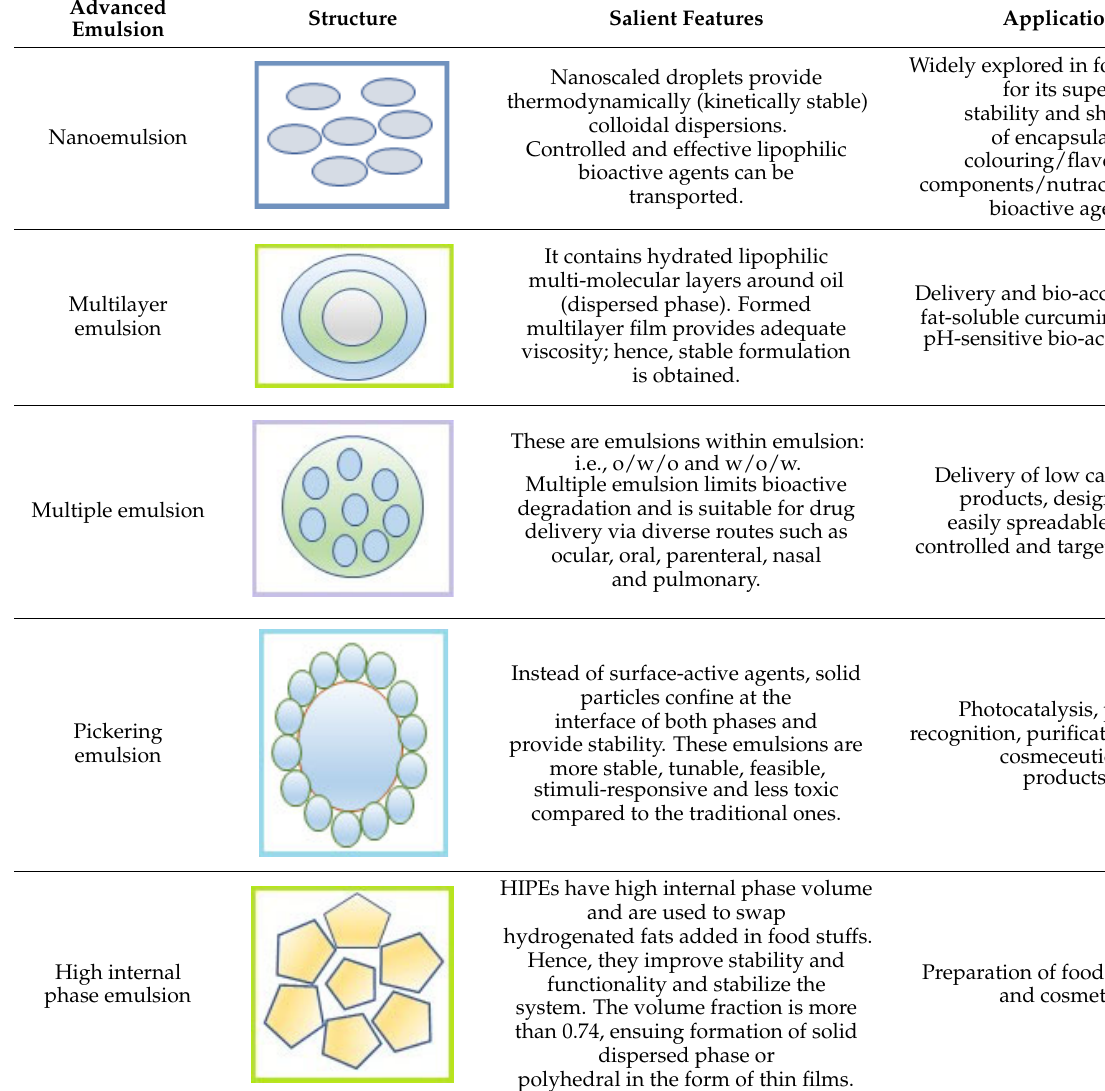
Table 1. Salient features and drug delivery applications of advanced emulsions.